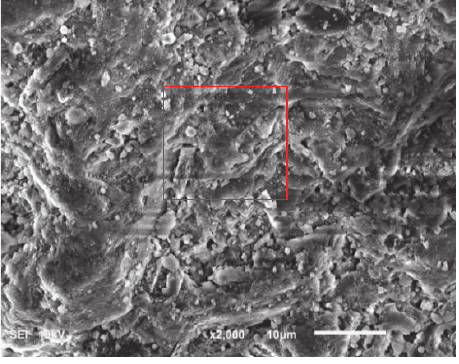
Figure 14: SEM images of Pd/Al 2 O 3 .